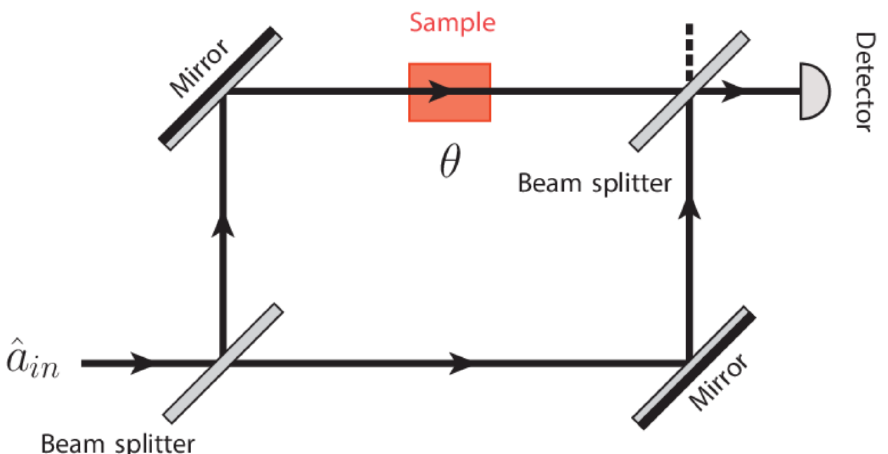
Figure 11. Sketch of the Mach–Zehnder interferometer for the measurement of the gas–density profile [37].